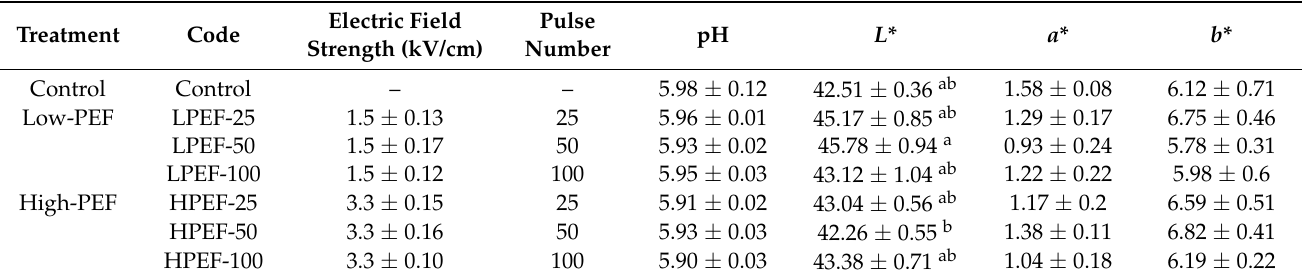
Table 2. Effect of different PEF treatments on pH and color content of chicken meat